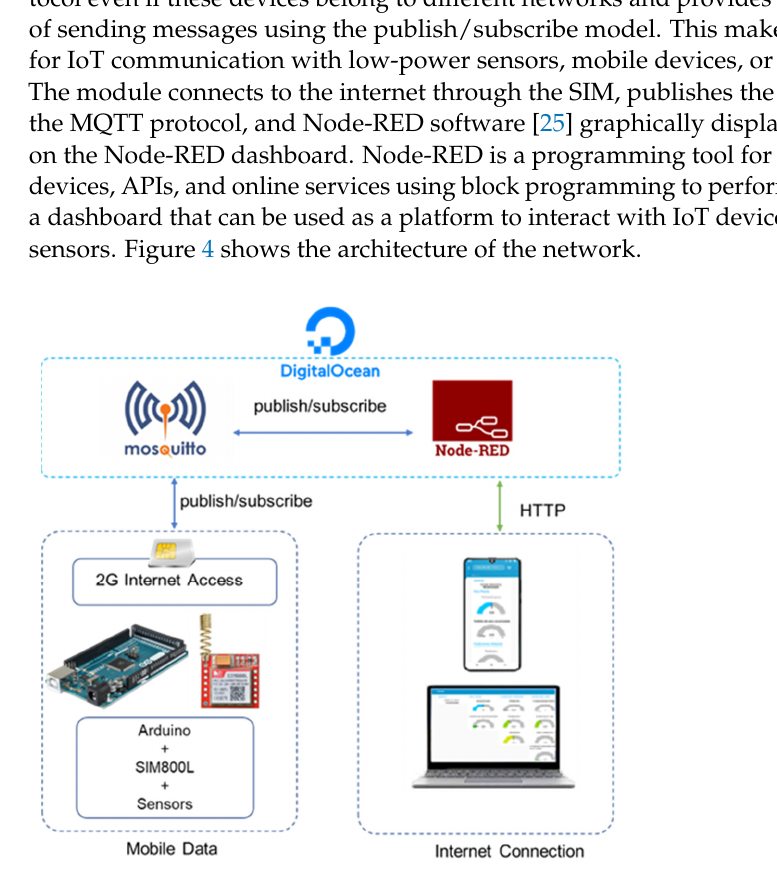
Figure 4. Hardware and software architecture.